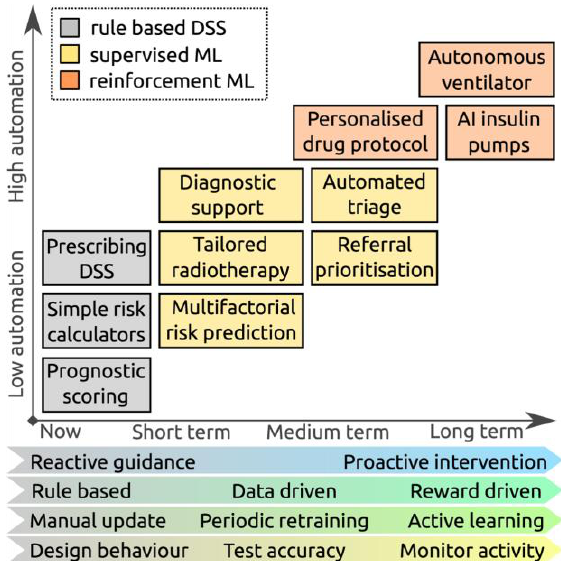
Figure 22. Expected trends in machine learning research: boxes show representative examples of decision support tasks that are currently offered by rule-based systems (grey), and hypothetical applications of ML systems in the future (yellow and orange), demonstrating increasing automa- tion. The characteristics of the ML systems that support these tasks are anticipated to evolve, with systems becoming more proactive and reward driven, continuously learning to meet more complex applications, but potentially requiring more monitoring to ensure they are working as expected.